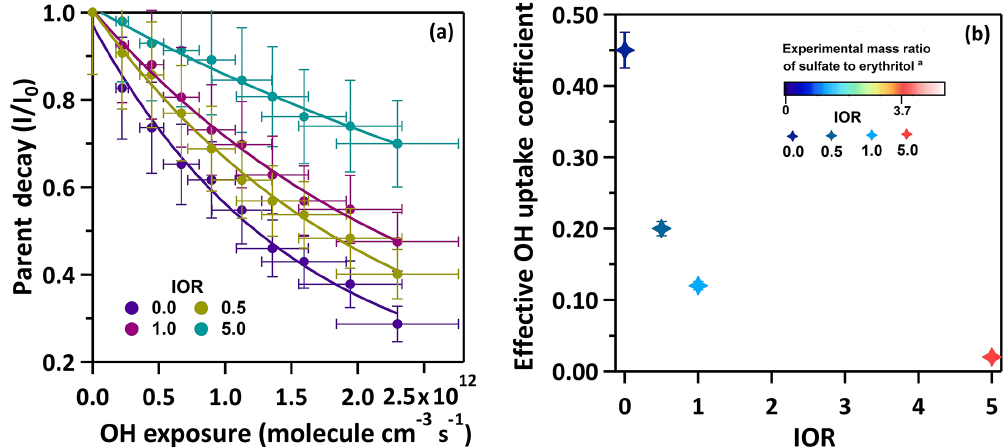
Figure 2. (a) The normalized decay of erythritol as a function of OH exposure during the heterogeneous OH oxidation of erythritol particles and erythritol–AS particles with different IORs. (b) The effective OH uptake coefficient, γ eff . The data points represent γ eff value at different IORs. The color scales represent the range of corresponding sulfate to erythritol mass ratio (0–3.7) at different IORs in this work, which is much smaller than that for ambient mass ratio of sulfate to 2-methyltetrols reported in field studies ( ∼ 1 . 89– ∼